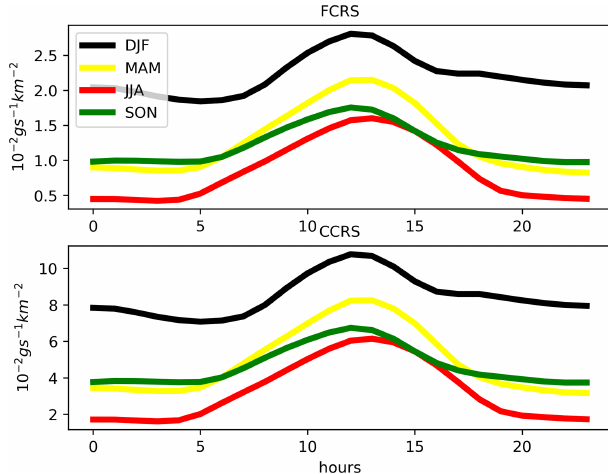
Figure 5. Domain-averaged diurnal cycle of hourly FCRS and CCRS WBD emission fluxes for different seasons for 2007–2016 (units are 10 − 2 gs − 1 km − 2